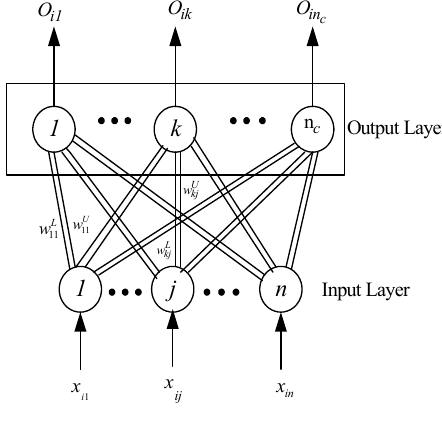
Figure 3. Basic structure of Extension Neural Network